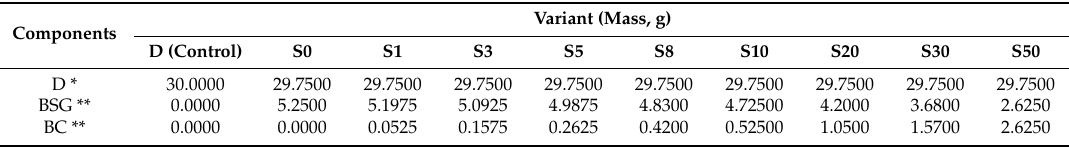
Table 2. Research variants, initial weight fraction of individual components (0% BC (S0) to 50% BC (S50) addition),